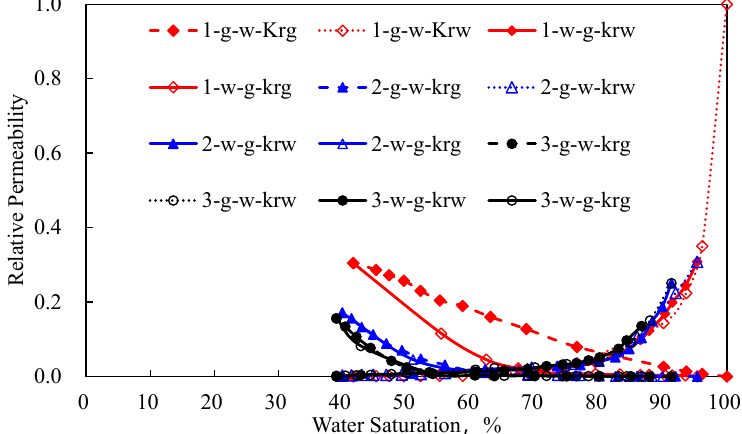
Figure 3. Relative permeability curves of gas/water in the highly permeable core.